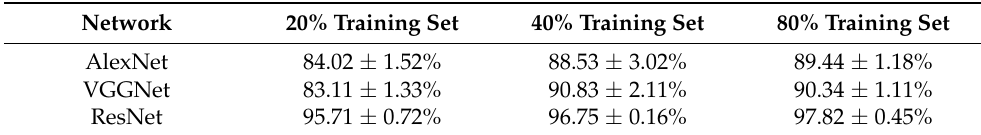
Table 4. Accuracy results for the NWPU-RESISC45 data sets.